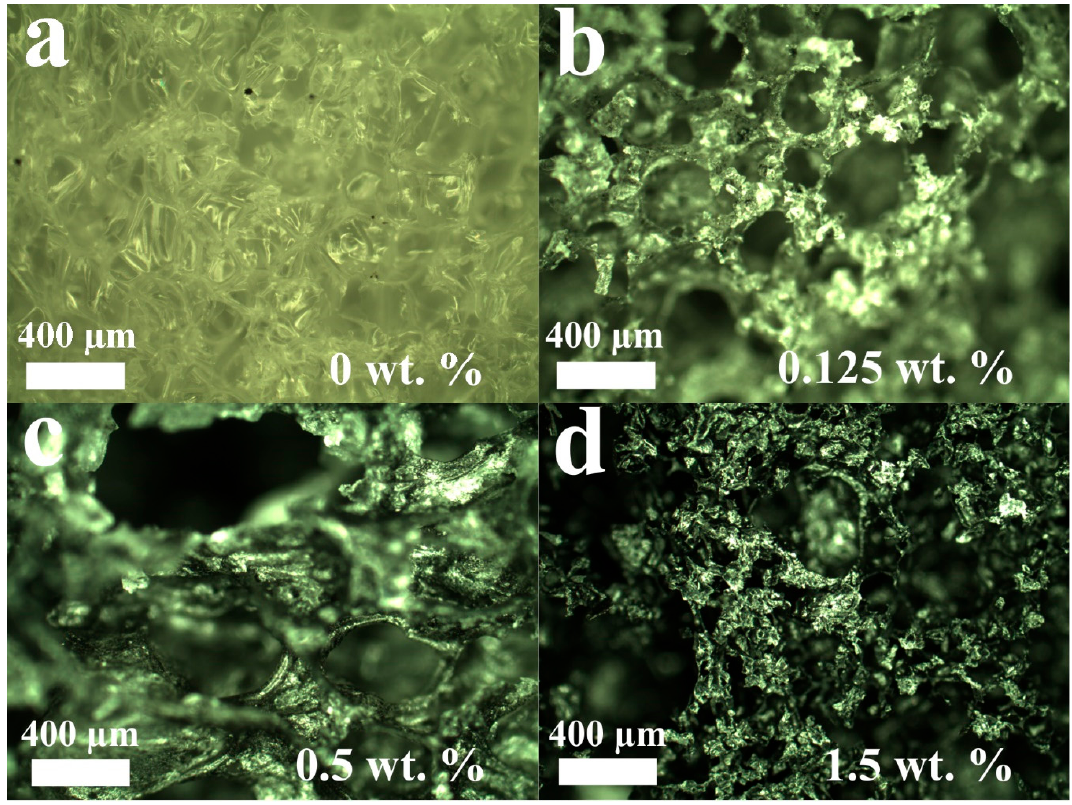
/ rGO sca ff olds. ( a – d ) demonstrate di ff erent rGO Figure 2. Optical images of PCL/rGO scaffolds. ( a – d ) demonstrate different rGO concentrations. Figure 2. Optical images of PCL